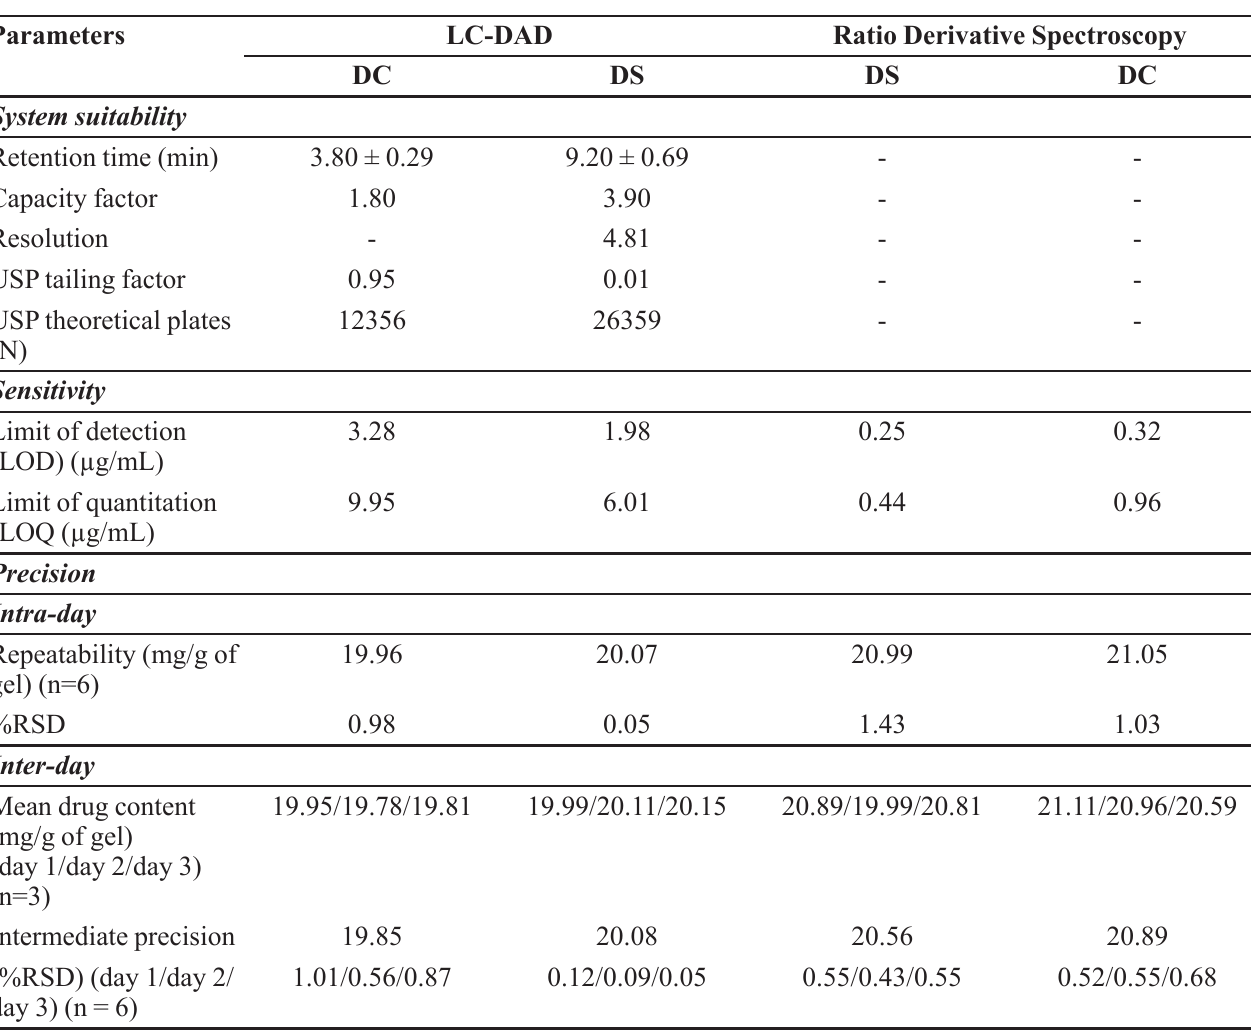
TABLE I - Validation data for the estimation of DC and DS from transdermal gel preparation based on LC-DAD and Ratio derivative